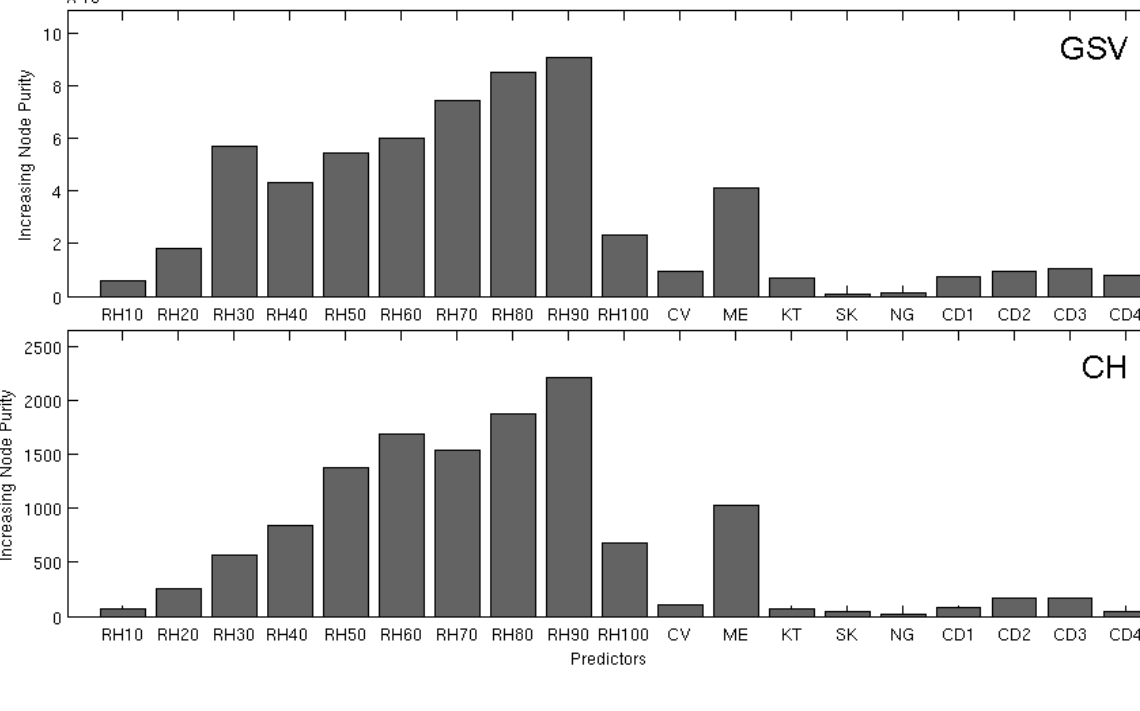
Figure 5. Allometric relationship between GSV and CH for radiata pine